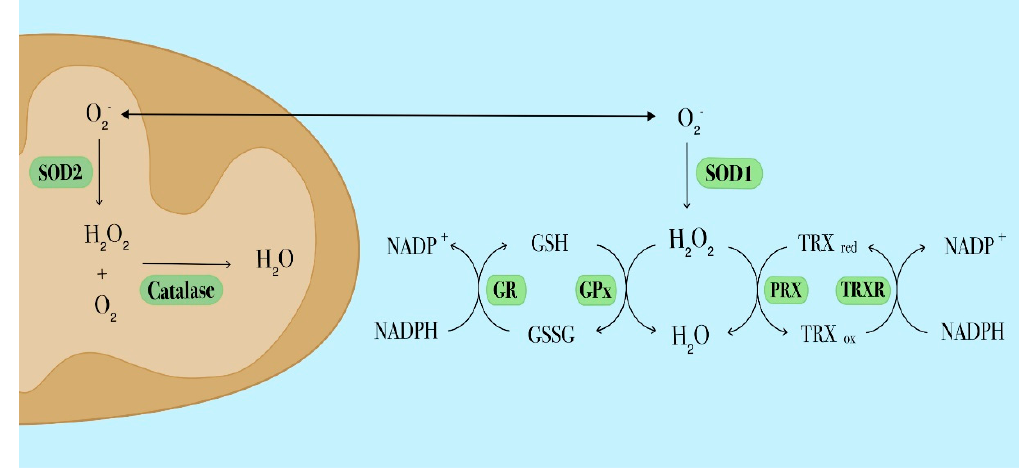
Figure 2. Schematic diagram depicting the main antioxidant systems in leukemia cells. The superoxide dismutase (SOD) catalyzes the dismutation of superoxide into molecular oxygen and hydrogen peroxide, which is then further processed by catalase. Intracellular SOD isoforms have different locations: SOD1 is located in the cytosol, SOD2 in mitochondria. The glutathione (GSH) antioxidant system comprises GSH, glutathione reductase (GR) and glutathione peroxidase (GPx). To perform its antioxidant function, GSH needs to be oxidized into GSSG via GPx. To restore reduced GSH levels, GSSG is converted by GR in a reaction that requires NADPH. The thioredoxin (TRX) antioxidant system involves TRX, peroxiredoxin (PRX) and thioredoxin reductase (TRXR). Reduced TRX catalyzes the reduction of disulfides within PRX. In this process TRX is oxidized (TRXox) and subsequently reduced (TRXred) by thioredoxin reductase (TRXR) through a NADPH-dependent mechanism.